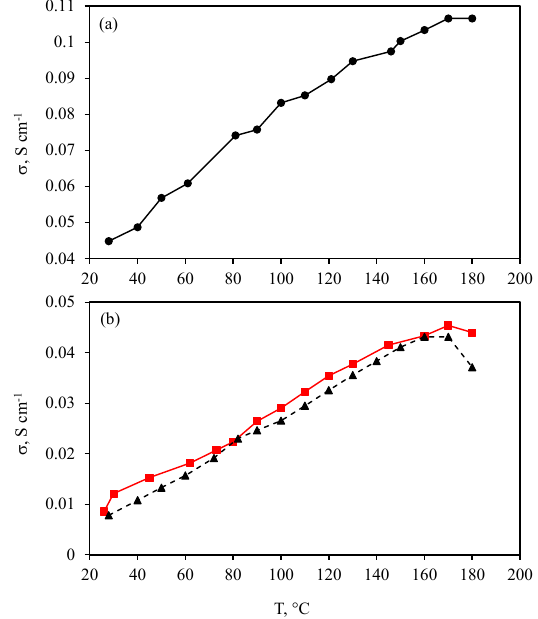
Figure 2. Proton conductivity data for the samples doped with phosphoric acid with an ( a ) electrospun m-PBI mat (es- m -PBI net ), and ( b ) initial PBI-O-PhT membrane (triangles) and composite PBI-O-PhT/es- m -PBI net · nH 3 PO 4 membrane (squares).